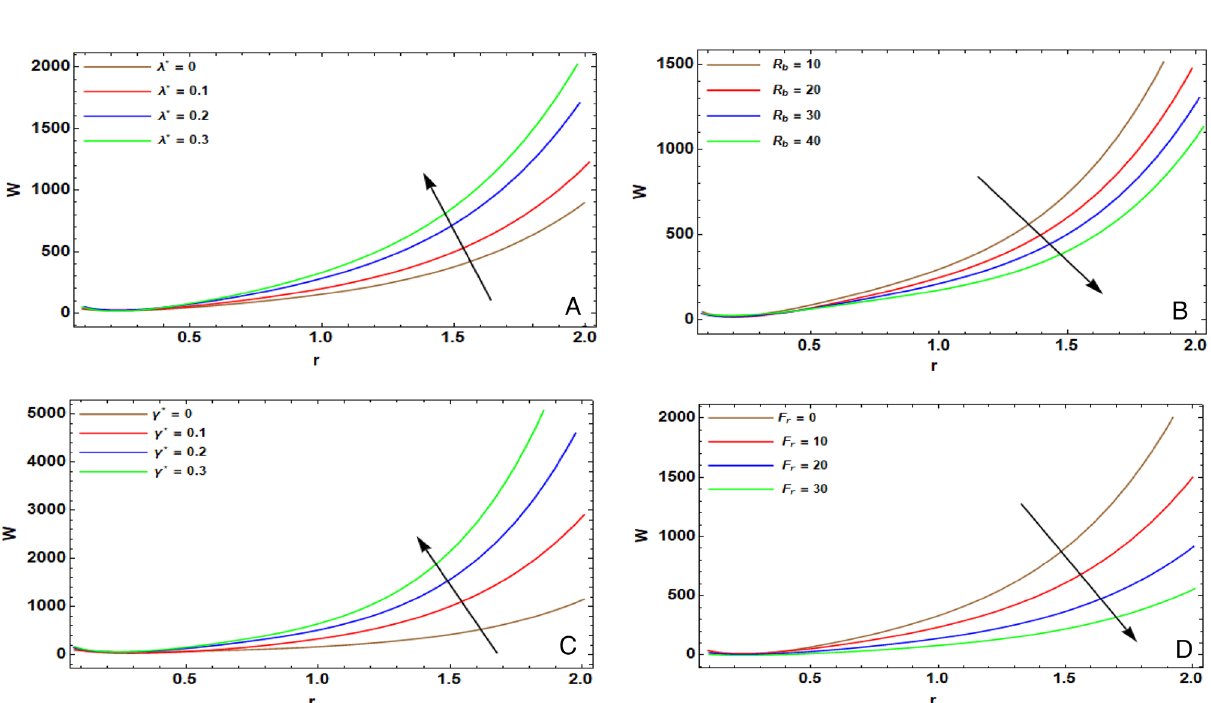
Figure 3. ( A ) implies alteration of w ( r ) for various amounts of (cid:31) ∗ . ( B ) implies alteration of w ( r ) for various amounts of R b . ( C ) implies alteration of w ( r ) for various amounts of γ ∗ . ( D ) implies alteration of w ( r ) for various amounts of F r